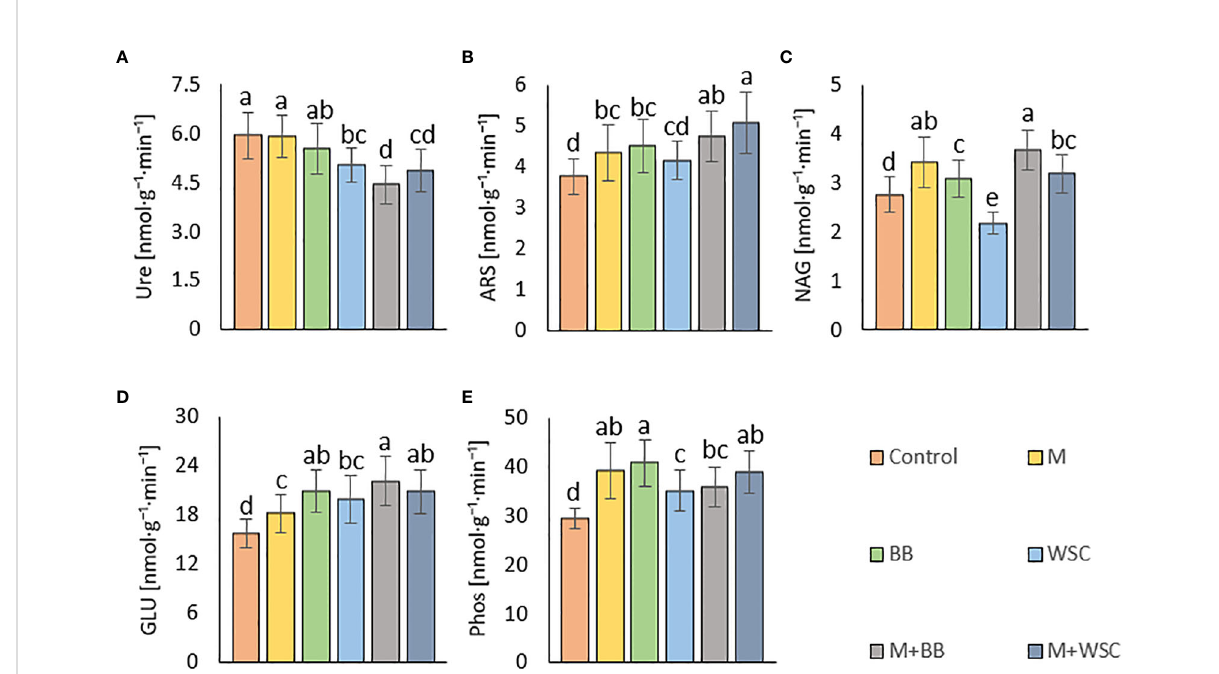
FIGURE 6 Soil enzyme activities - (A) urease, Ure; (B) arylsulfatase, ARS; (C) N-acetyl- b -D-glucosaminidase, NAG; (D) b -glucosidase, GLU; (E) phosphatase, Phos; of the control (no digestate) and all variants amended with digestates made from single crop and mixed cultures, n=27. Mean ± standard error of mean (error bars); different letters indicate statistically signi fi cant differences at the signi fi cance level p ≤